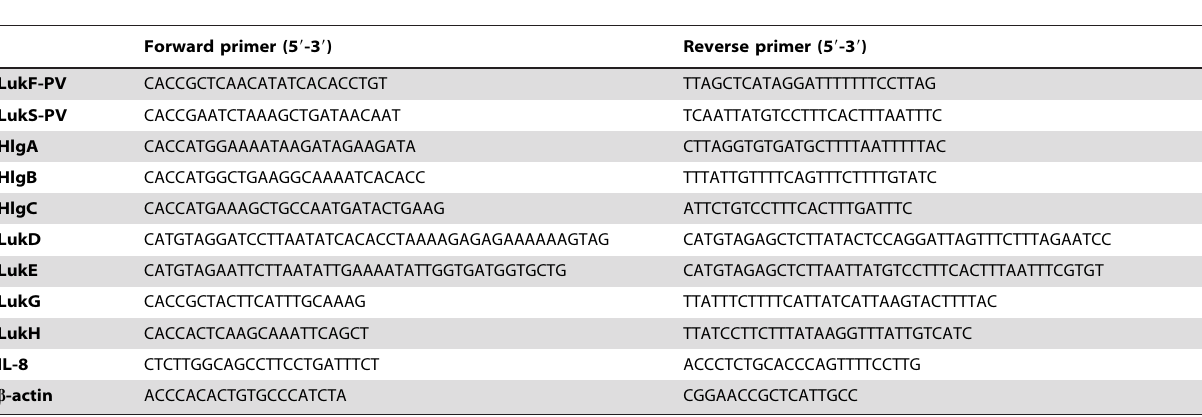
Table 1. Primers used for plasmid construction and reverse-transcription